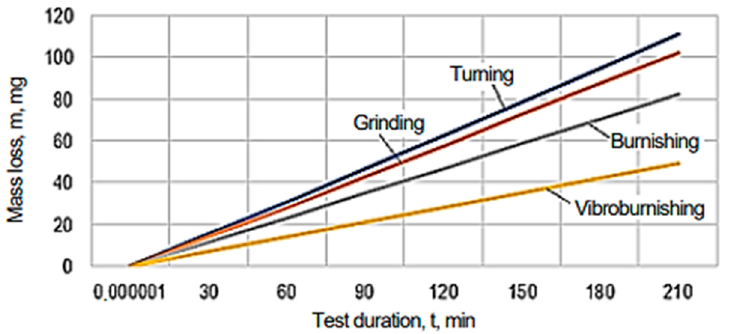
Figure 12. The influence exerted by the process duration t on the mass lost Δ m for different machining processes applied to the tested surfaces ( p = 70,000 Pa).